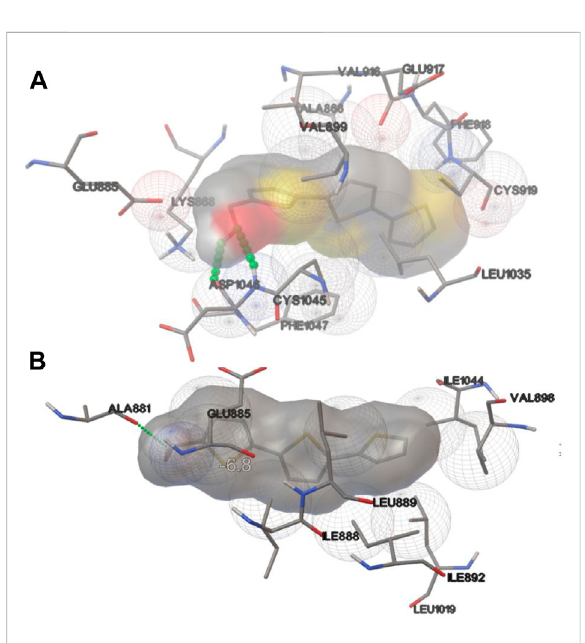
FIGURE 6 (A) Lowest energy docked structure for the VEGFR2/ compound 3 complexatthesitesharedwithsorafenibandaxitinib. (B) A secondary pose at the site HYD-II. Both structures were used as initial geometries for the MD